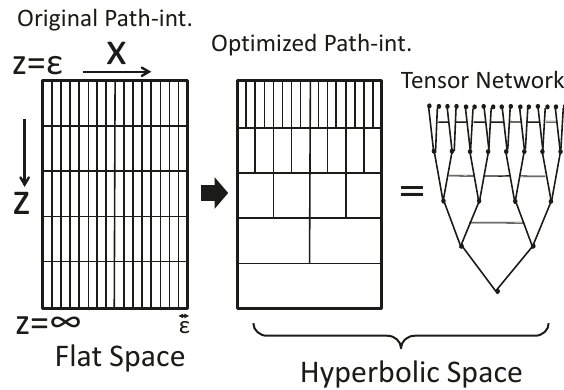
Figure 1 . Computation of a ground state wave function from Euclidean path-integral (left) and its optimization (middle), which is described by a hyperbolic geometry. The right (cid:12)gure schematically shows its tensor network